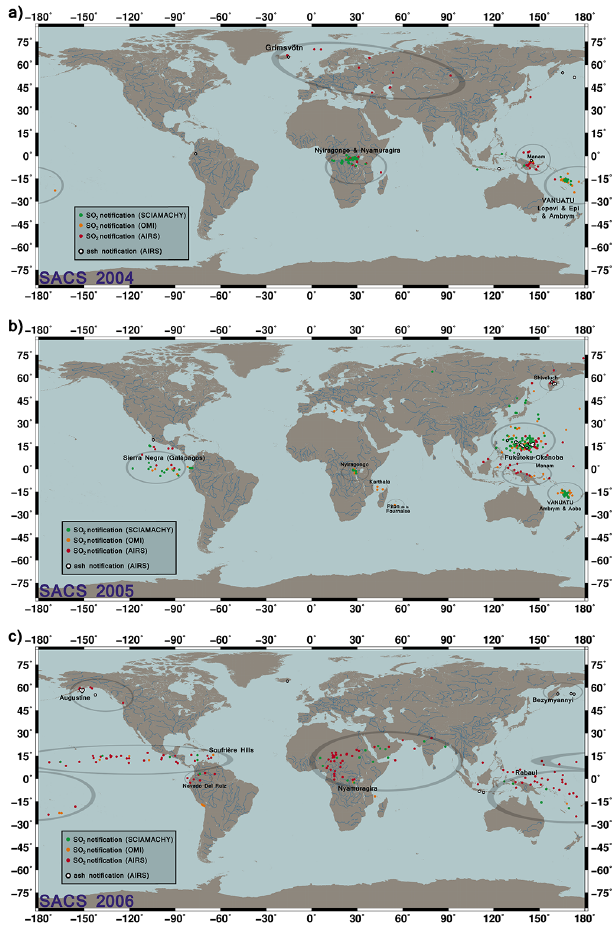
Fig. 13b. The signatures of two additional major